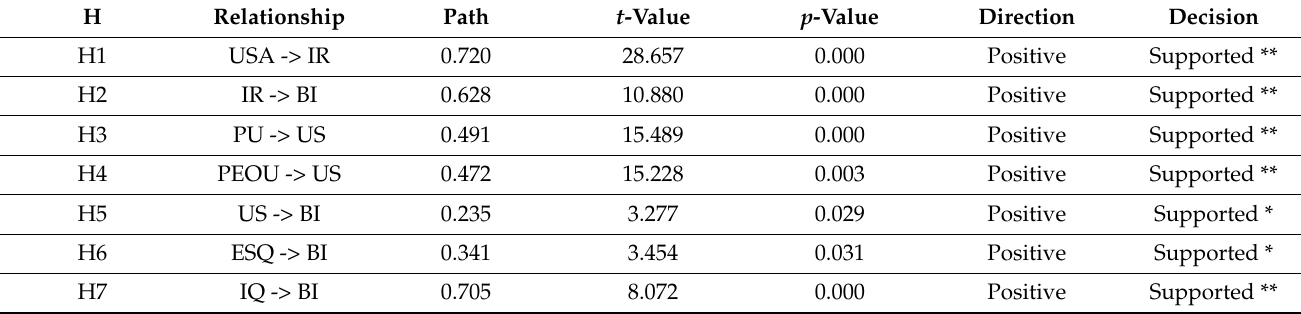
Table 10. Hypotheses testing of the research model (significant at ** p ≤ 0.01, * p <